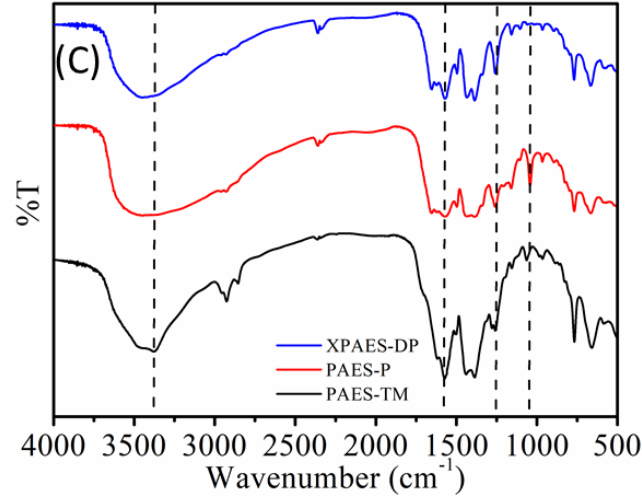
Figure 1. 1 H NMR spectra of ( a ) PAES-Me and ( b ) PAES-MeBr to confirm the stepwise functionalization of PAES, and ( c ) FT-IR spectra of three synthesized membranes, XPAES-DP, PAES-P, and PAES-TM.